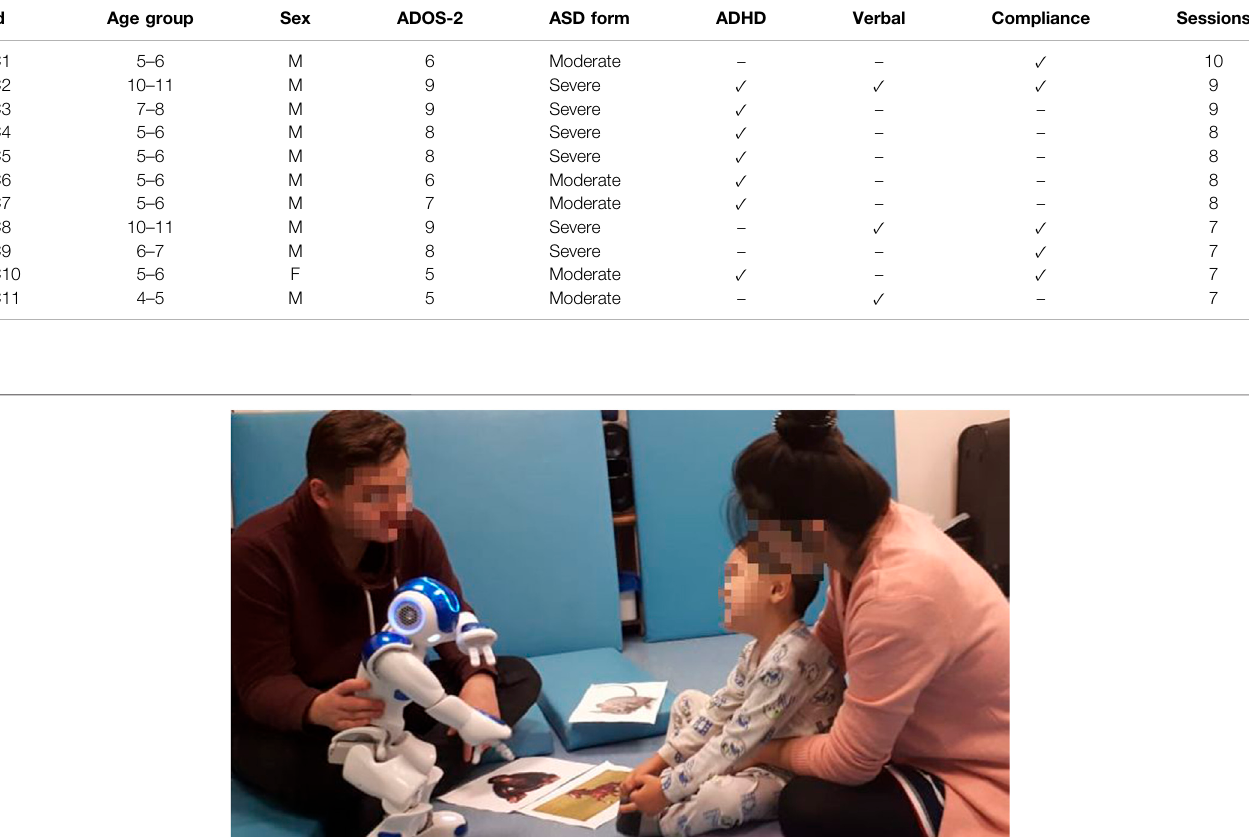
TABLE 1 | Children ’ s demographics and other characteristics (ADOS-2 score, ASD form, presence of co-occurring ADHD, verbal or nonverbal autism), compliance to therapists ’ instructions, and the number of attended sessions.